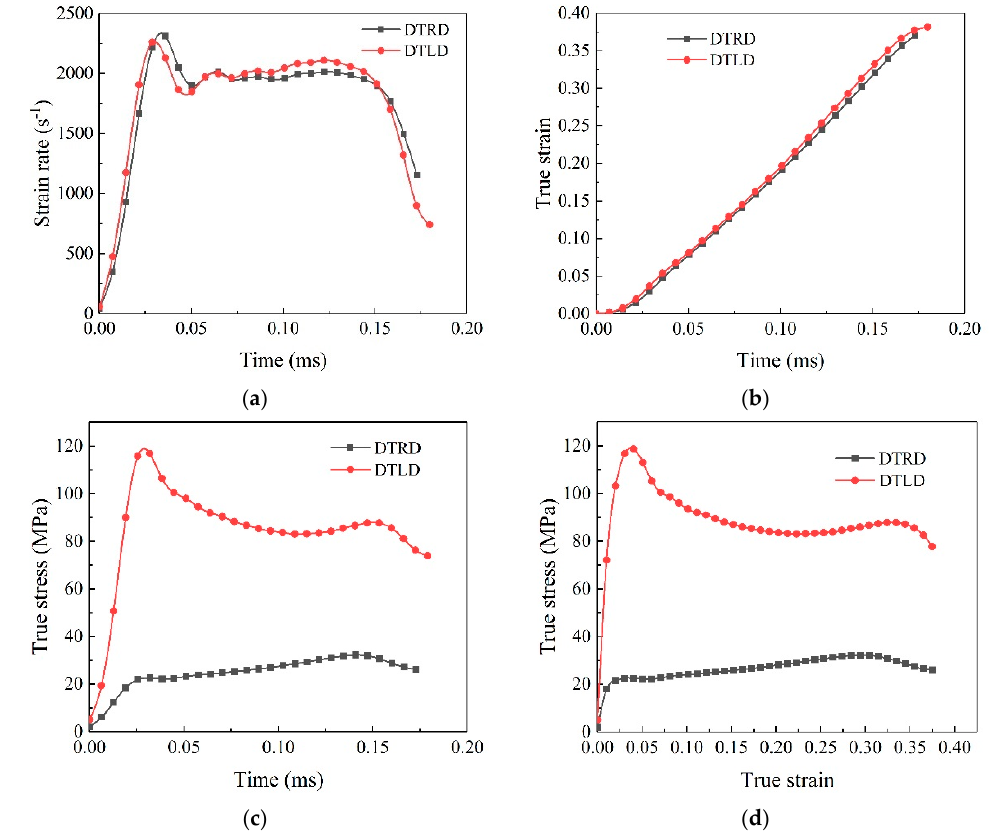
Figure 7. Representative curves of specimens in DTRD and DTLD under the strain rate of 2000 s − 1 : ( a ) strain rate–time curves, ( b ) strain–time curves, ( c ) stress–time curves, and ( d ) stress–strain curves.